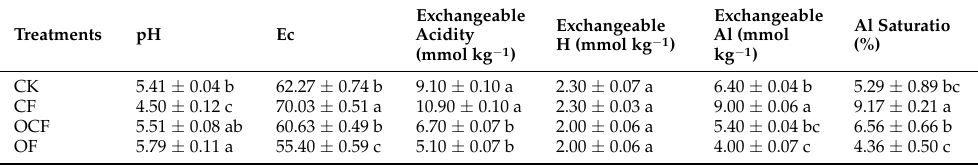
Table 2. Changes in pH, Ec and soil exchangeable acid under different fertilization treatments. Treatments pH